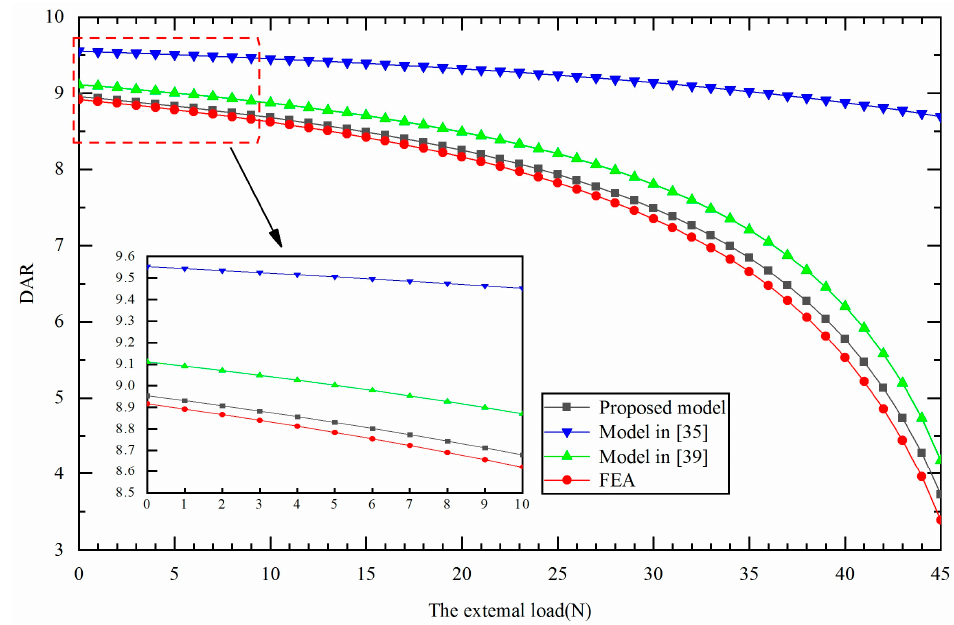
Figure 5. The changes in DAR with varied external